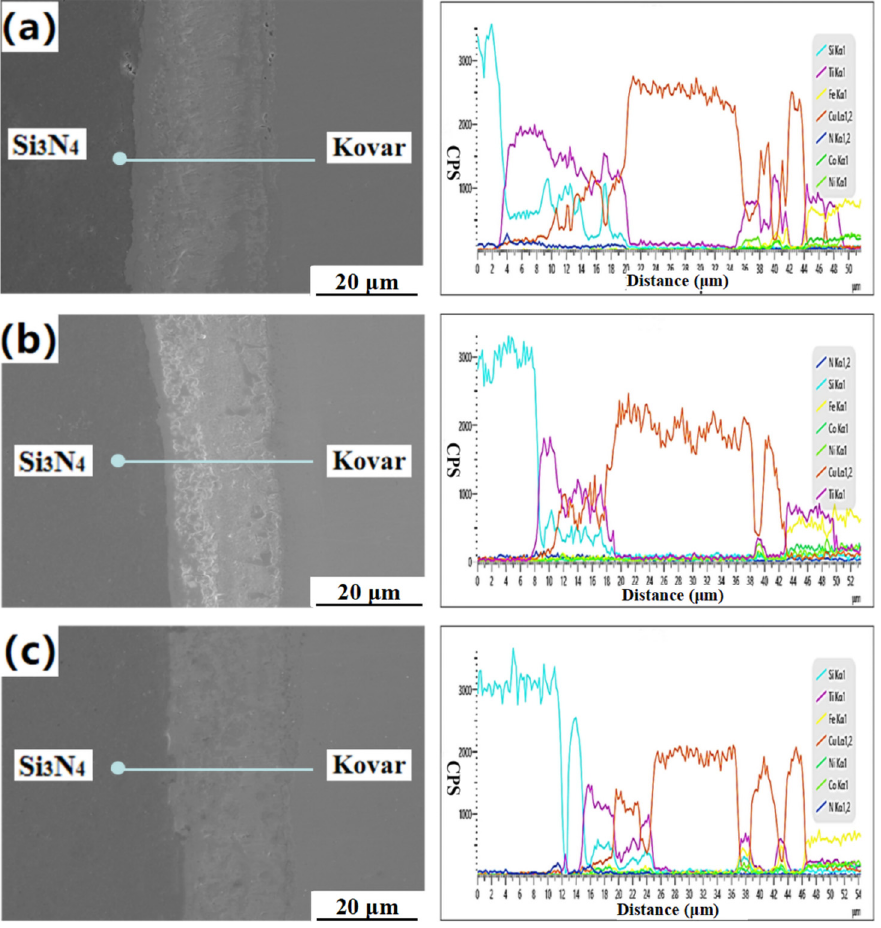
Figure 7. Line scanning spectrogram of Si 3 N 4 /Ti/Cu/Kovar interface at ( a ) 940 °C, ( b ) 1000 °C and ( c ) 1060 °C. Table 3. Component content of each point in Figure 7 (at.%).